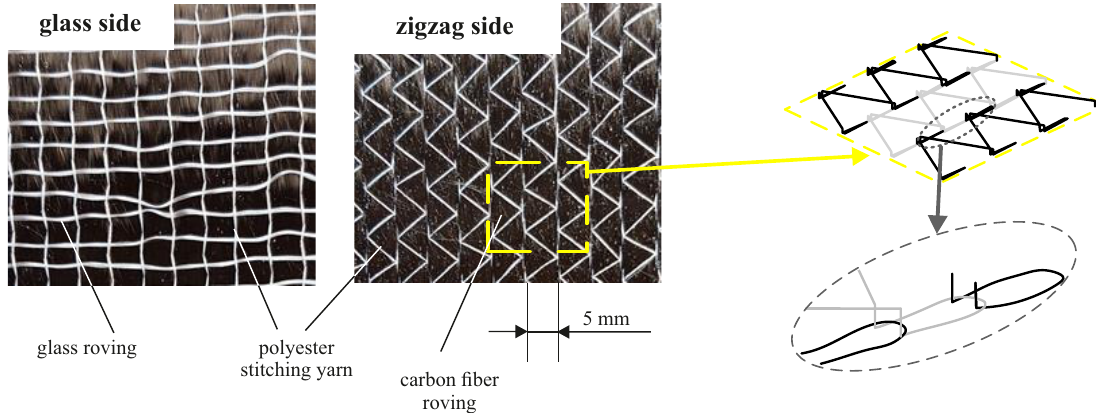
Figure 2. Zoltek PX35 unidirectional non-crimped carbon fiber